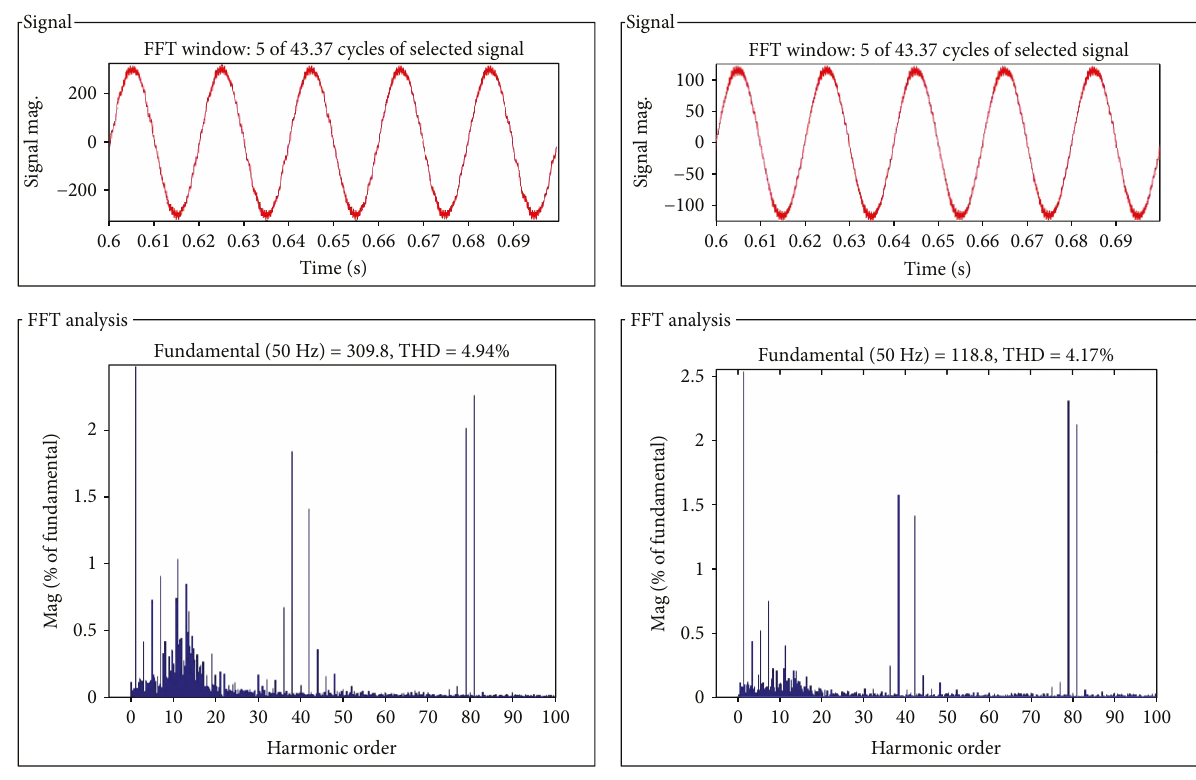
Figure 15: FFT analysis of a PVSES